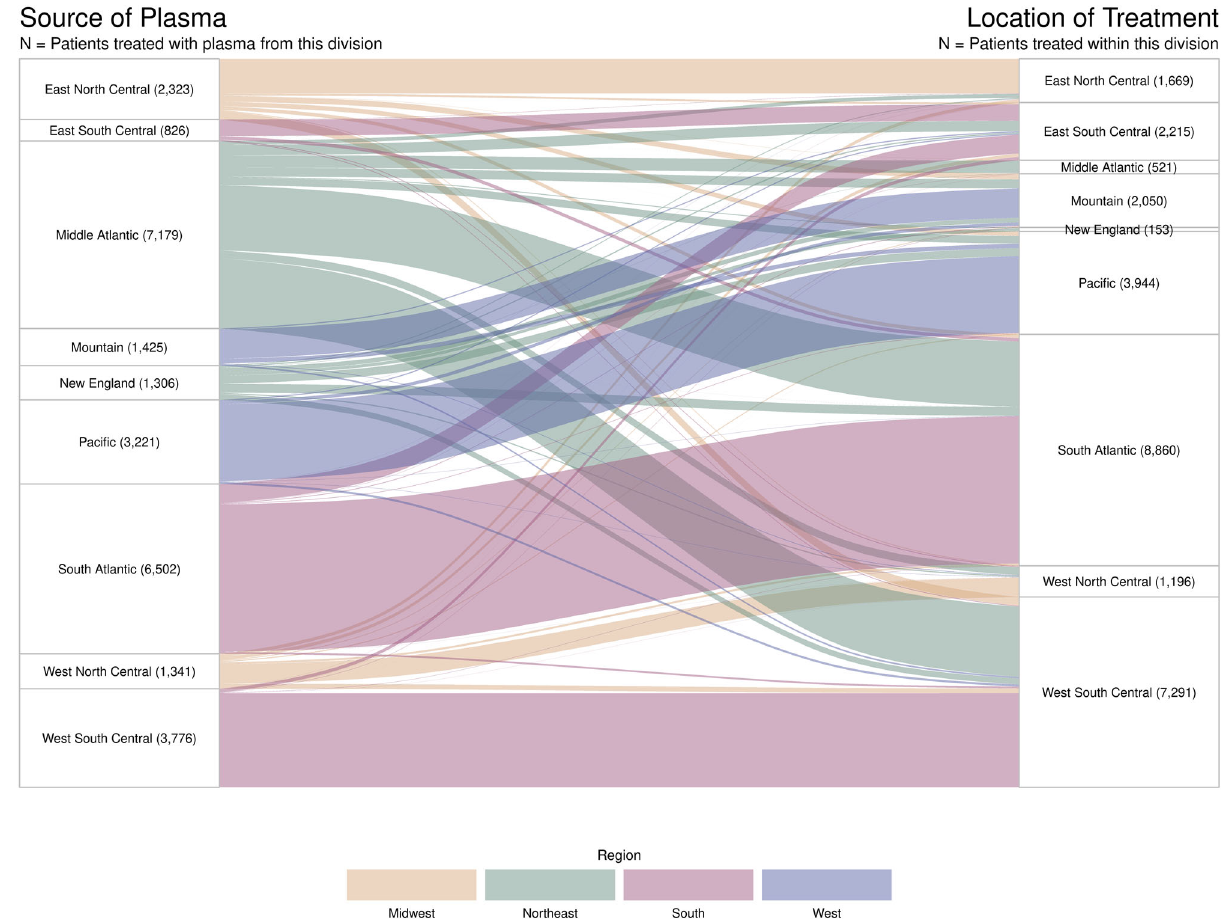
Fig. 1 Sankey diagram of movement of convalescent plasma units between US Census regions and divisions. Flow of convalescent plasma units from the location of their collection to the location of treatment is depicted by lines connecting divisions of the US. The width of each line is proportional to the number of patients treated. The color of each line represents the US Census region from which the convalescent plasma was donated. Note that low rates of transfusions in the Middle Atlantic and New England divisions, which make up the Eastern region, are due to a combination of the analysis time window and the exclusion of mechanically ventilated